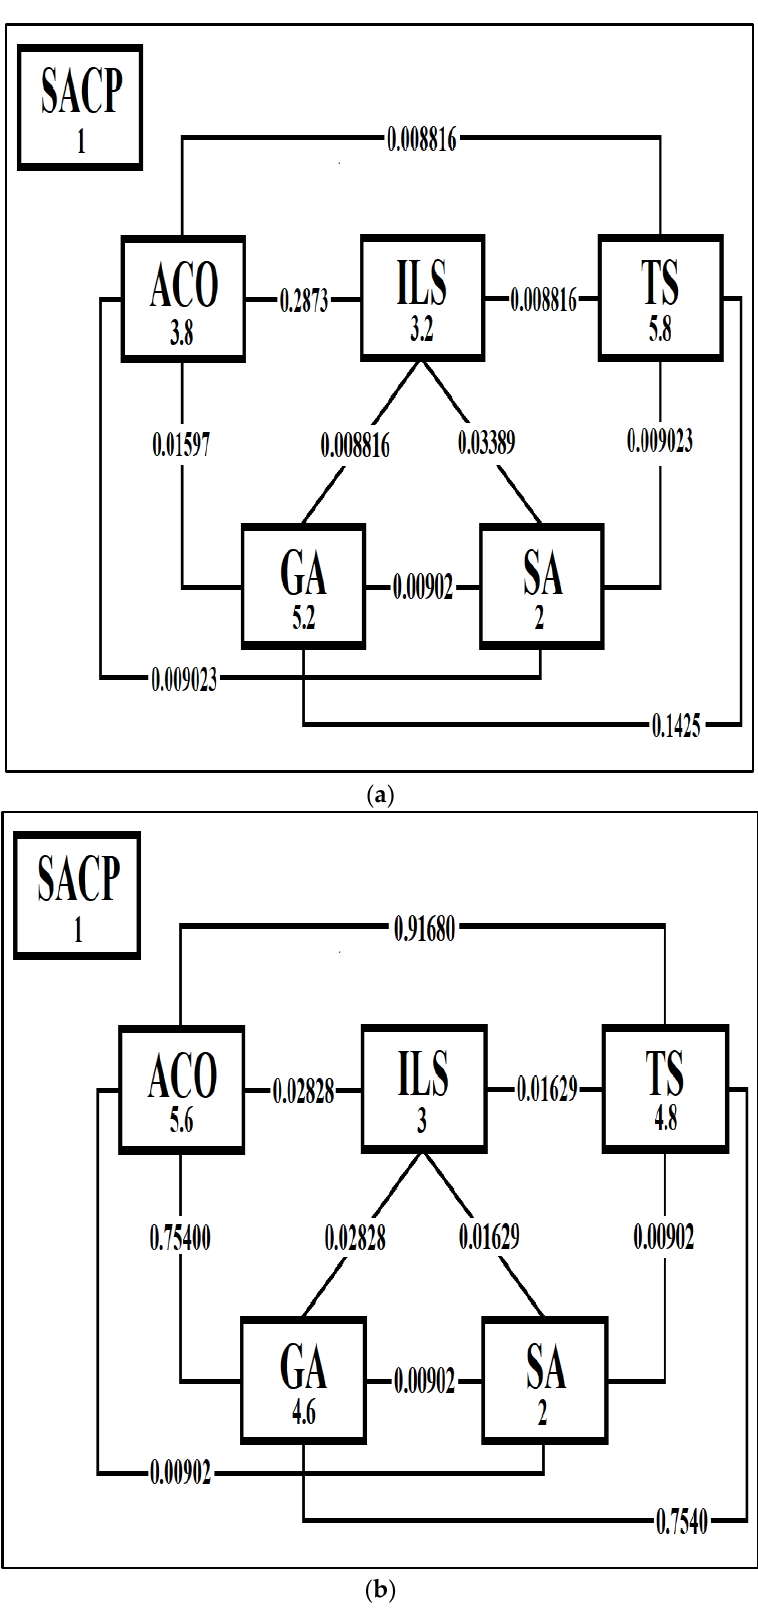
Figure 14. Graph of the p -values and average ranking between the compared algorithms. ( a ) Small instances. ( b ) Medium instances.